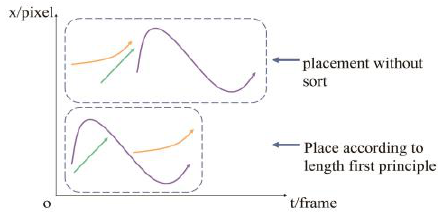
Fig. 5. Length priority within